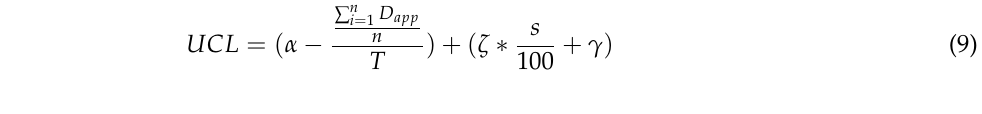
Algorithm 1 Calculate UCL = E apputil + E costSavings